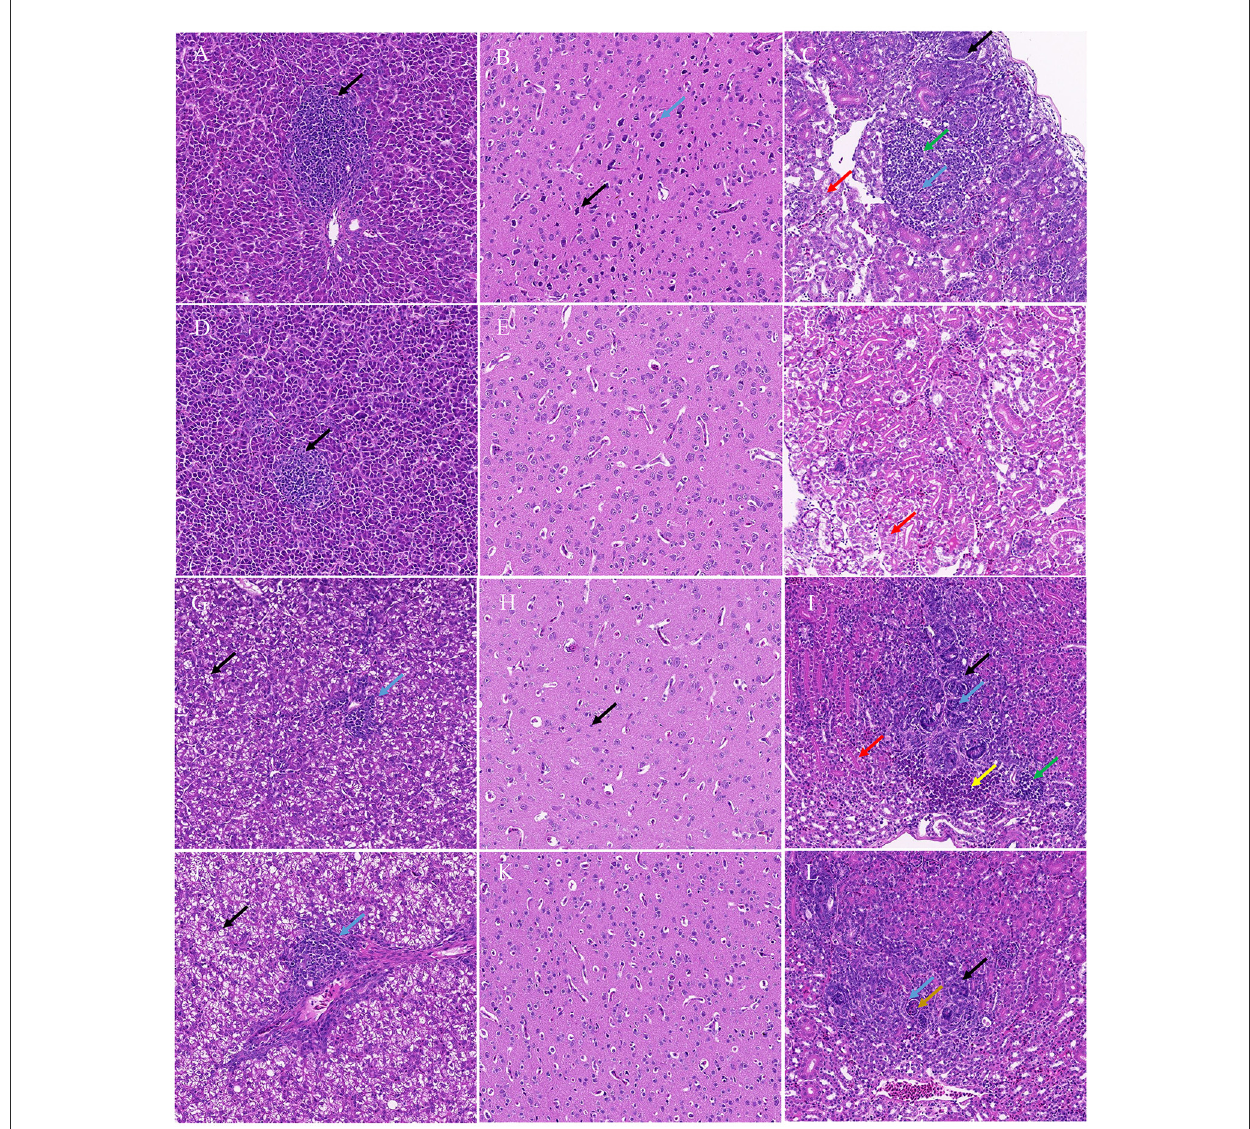
FIGURE4 Histopathological lesions. (A) Liver, TMUV-GX-infected chicks: lymphoid infiltration (black arrow); (B) Brain, TMUV-GX-infected chicks: neuronal pyknosis, enhanced basophilic cytoplasm (black arrow) and increase in microglia (blue arrow); (C) Kidney, TMUV-GX-infected chicks: renal tubular atrophy, luminal stenosis (black arrow), multiple epithelial cell necrosis, nuclear pyknosis (blue arrow), lymphoid infiltration (green arrow), and hydropic degeneration of renal tubular epithelial cells (red arrow); (D) Liver, TMUV-JM-infected chicks: lymphoid infiltration (black arrow); (E) Brain, TMUV-JM-infected chicks; (F) Kidney, TMUV-JM-infected chicks: some hydropic degeneration of renal tubular epithelial cells (red arrow); (G, J) Liver, TMUV-infected ducklings: diffuse hydropic degeneration of hepatocytes (black arrow) and some lymphoid infiltration (blue arrow); (H) Brain, TMUV-GX-infected ducklings: increase in microglia (black arrow); (I) Kidney, TMUV-GX-infected ducklings: renal tubular atrophy, luminal stenosis (black arrow), multiple epithelial cell necrosis, nuclear pyknosis (blue arrow), lymphoid infiltration (green arrow), hydropic degeneration of renal tubular epithelial cells (red arrow), and hemorrhage (yellow arrow); (K) Brain, TMUV-JM-infected ducklings; (L) Kidney, TMUV-JM-infected ducklings: renal tubular atrophy, luminal stenosis (black arrow), multiple epithelial cell necrosis, nuclear pyknosis (blue arrow), and necrotic cell mass (brown